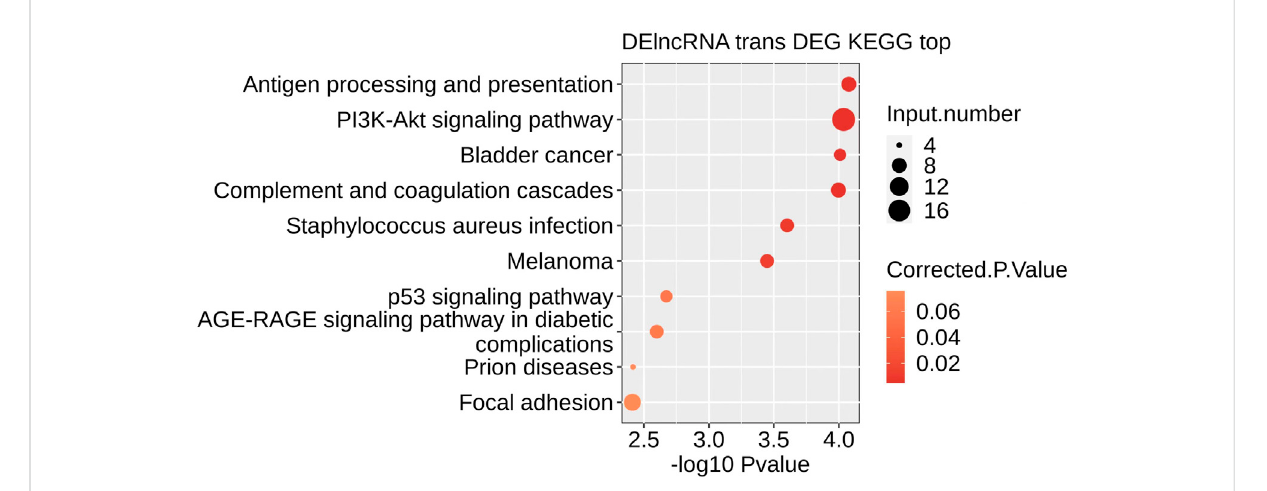
FIGURE 6 The result of KEGG enrichment